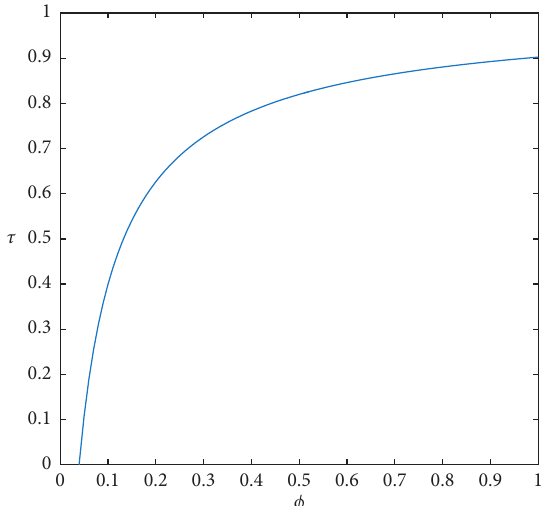
Figure 2: The two-dimensional relationship between the ecological compensation rate and pollution transfer coefficient.